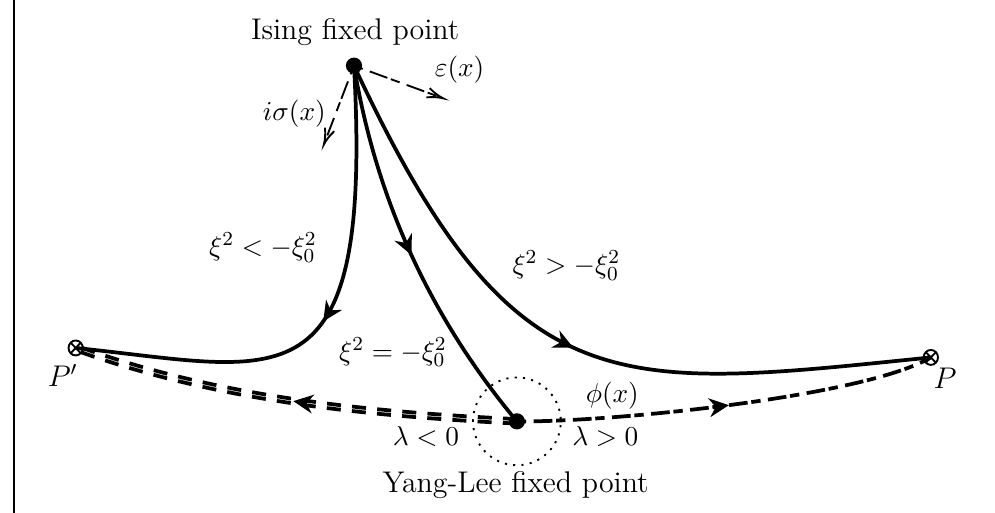
Figure 2 . The topology of the RG flow at pure imaginary h . Critical and non-critical RG fixed points are given by bullets and crossed circles respectively. Some RG trajectories originated from Ising fixed point are shown with solid arrowed lines. The trajectories are labeled by ξ 2 , and ξ 2 = − ξ 2 denotes the massless flow down to YL fixed point. Single and double dashed lines are showing the RG flows from the Yang-Lee fixed point to non-critical fixed points P and P 0 , with positive and negative λ